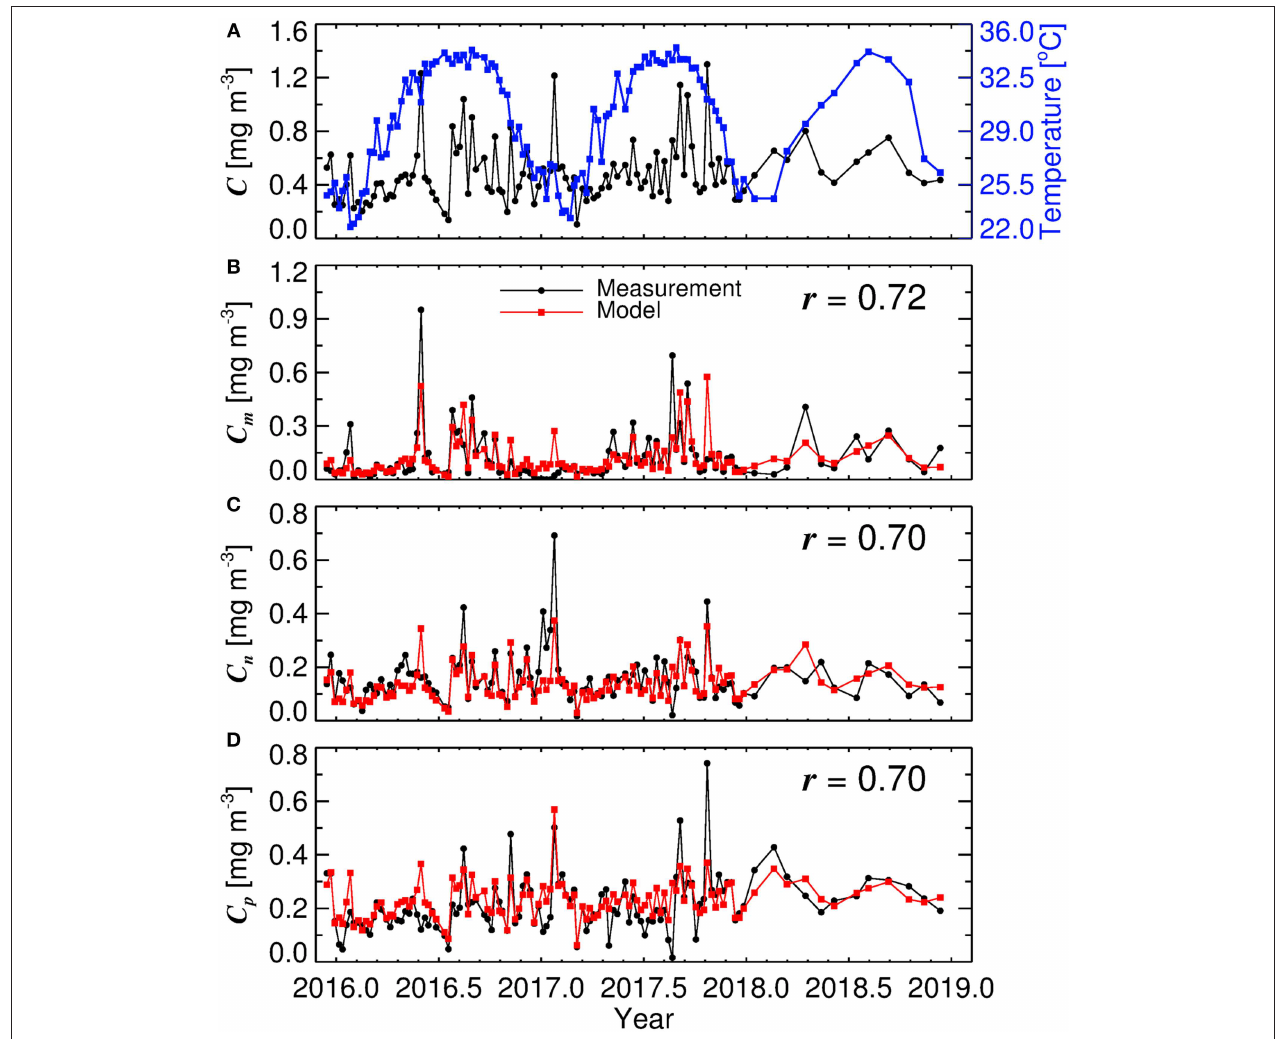
FIGURE 5 | Time-series of data collected at KAUST harbor in Thuwal between 2016 and 2019. (A) time-series of water temperature and total chlorophyll ( C ), (B) microphytoplankton chlorophyll ( C m ), (C) nanophytoplankton chlorophyll ( C n ), and (D) picophytoplankton chlorophyll ( C p ). r represents the correlation coefficient between measurements and model (conducted in linear